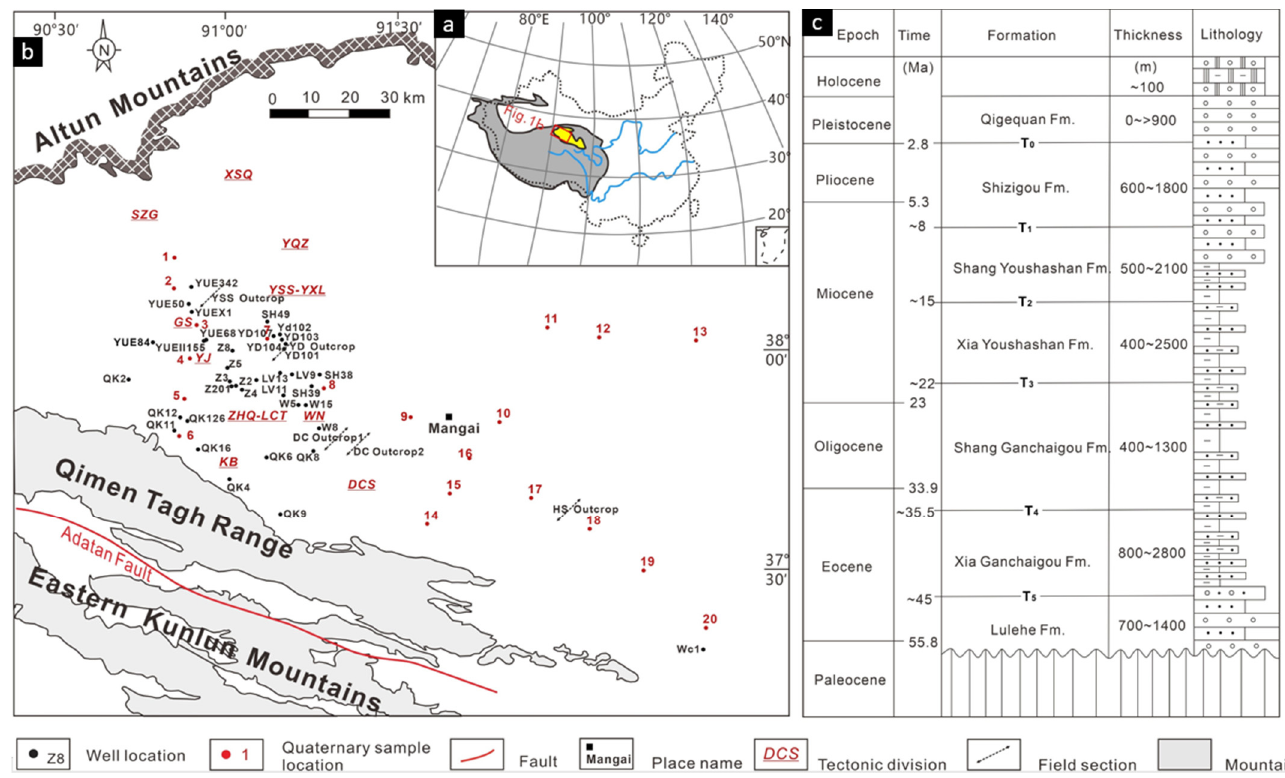
Figure 1. ( a ) Location of the Qaidam Basin on the Tibetan Plateau; ( b ) locations of sampling wells and outcrops in southwestern Qaidam Basin. XSQ: Xianshuiquan; SZF: Shizigou; YQZ: Youquanzi; YSS-YXL: Youshashan-Yingxiongling, GS: Gasi, YJ: Yuejin, ZHQ-LCT: Zhahaquan-Lvcaotan, WN: Wunan, DCS: Dongchaishan, YSS Outcrop: Youshashan Outcrop, YD Outcrop: Yingdong Outcrop, DC Outcrop: Dongchaishan Outcrop, HS Outcrop: Huangshi Outcrop; ( c ) generalized Cenozoic stratigraphy column and seismic reflectors (T0–T5) (modified after